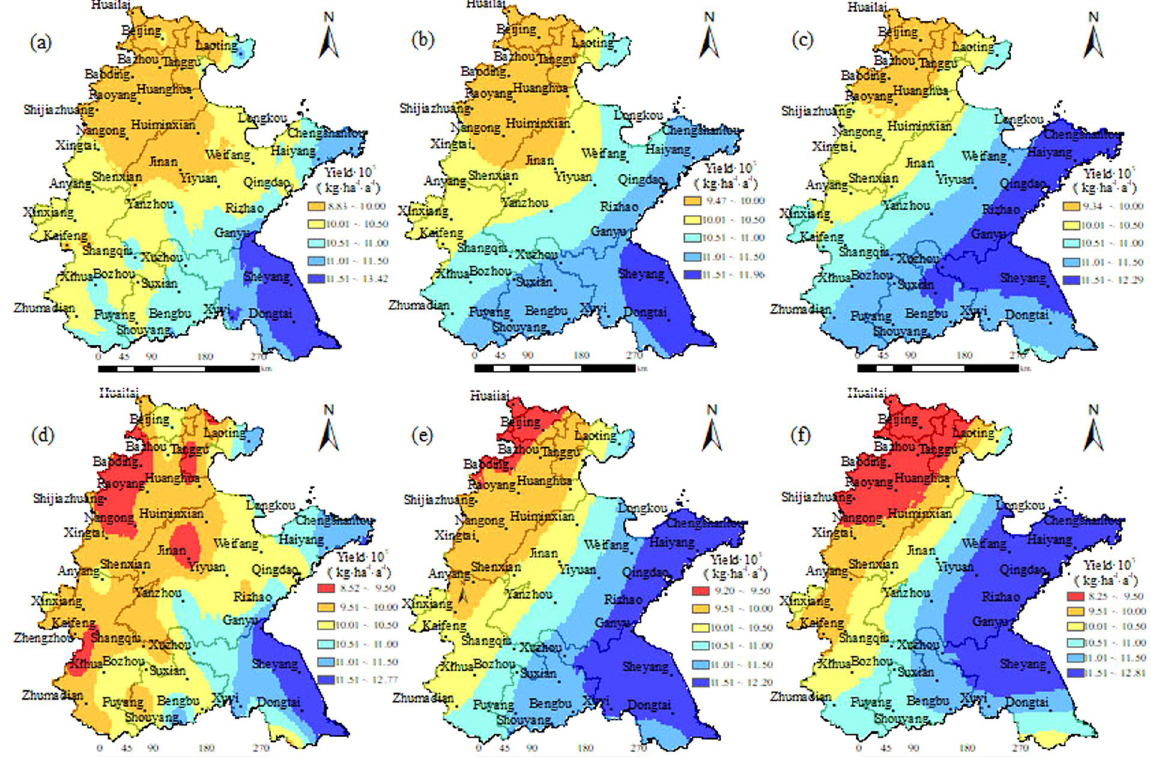
Figure 5. Spatial distributions of simulated winter wheat yields by the modified DSSAT model with the calibrated Hargreaves model and a dynamic Kc function in Huang-Huai-Hai Plain in 2020s, 2050s, 2080s under RCP4.5 ( a – c ) and RCP8.5 ( d – f ),